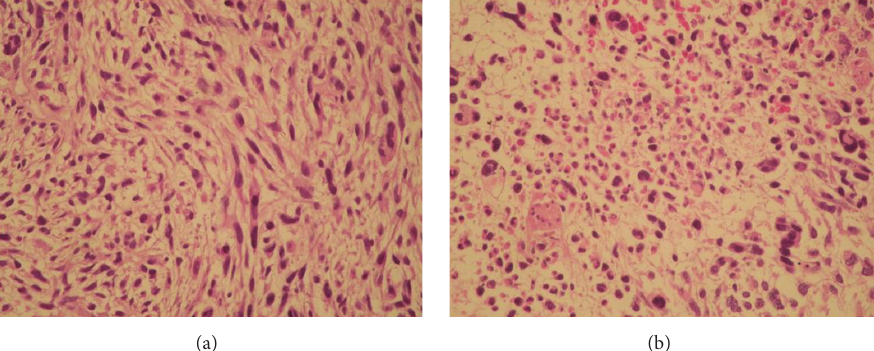
Figure 1: (a) Leiomyosarcoma composed of a dominant population of neoplastic spindle cells: (a) intermingled with giant neoplastic cells and multifocal and multifocal necrosis (b). Reproduced from [13].